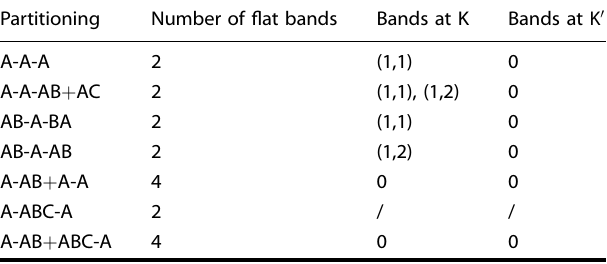
The band structures are measured with full continuum model considering nearest neighbor for untwisted bands. We label m bands with dispersion E ( k ) ~ k n at K μ ð K 0 μ Þ as